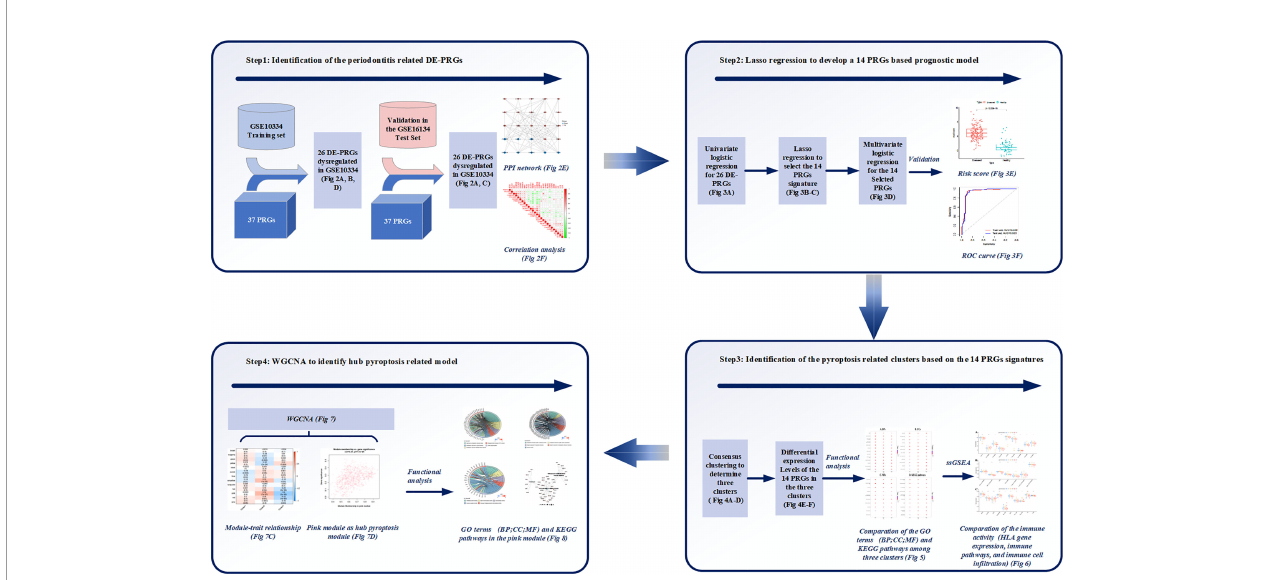
FIGURE 1 | Study work fl ow. Step1: 26 differentially expressed (DE)-pyroptosis-related genes (PRGs) were determined by merging the expression pro fi les of GSE10334 and 37 obtained PRGs. The 26 DE-PRGs were further validated in another periodontitis dataset (GSE16134). Protein-protein interaction (PPI) network and correlation analysis were conducted to investigate the interaction and correlation between the 26 DE-PRGs; Step2: The prognostic value of the 26 DE-PRGs in periodontitis (Training set) was assessed by univariate logistic regression analysis, and least absolute shrinkage and selection operator (LASSO) regression was applied to screen 14 prognostic PRGs from the 26 DE-PRGs. Then, a 14-PRGs signature model was developed based on multivariate logistic regression analysis. The risk scores and receiver operating characteristic (ROC) curves were applied for the model validation; Step3: Consensus clustering was applied based on the 14 signatures, and three pyroptosis-related clusters were determined. Differential expression levels of the 14 PRGs were compared among the three clusters. Functional analysis was applied to compare the Gene Ontology (GO) terms, including Biological Processes (BP), Cellular Components (CC), and Molecular Functions (MF), as well as Kyoto Encyclopedia of Genes and Genomes (KEGG) pathways among the three clusters. Single-sample gene set enrichment analysis (ssGSEA) were applied to compare the immune activities among the three clusters. Step4: Weighted correlation network analysis (WGCNA) identi fi ed the pink module as the hub pyroptosis-related module based on the module-trait relationship. Functional analysis was conducted for the pink module, in order to explore the role of pyroptosis in